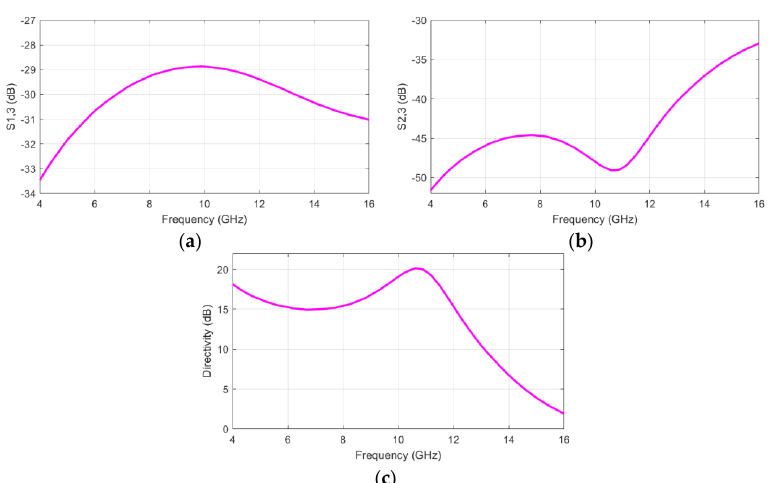
Figure 5. Optimized design of the coupler (final optimized responses highlighted in purple). ( a ) Coupling factor (S 13 ). ( b ) Isolation (S 23 ). ( c ) Directivity computed as D(dB) = S 13 (dB) − S 23 (dB).